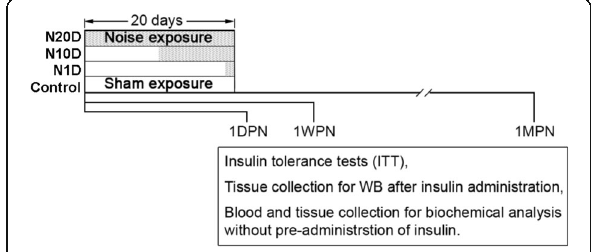
Fig. 1 Experimental timeline. The animals were randomly divided into four groups: a control group without noise exposure and three noise groups exposed to white noise at a 95-dB SPL at 4 h/day for 1, 10, or 20 days (N1D, N10D, and N20D, respectively) as indicated by the gray area within the 20-day period. The animals in each group were further subdivided into three subgroups according to when end-point evaluations were performed [1 day, 1 week, and 1 month post the cessation of noise exposure (1DPN, 1WPN, and 1MPN,